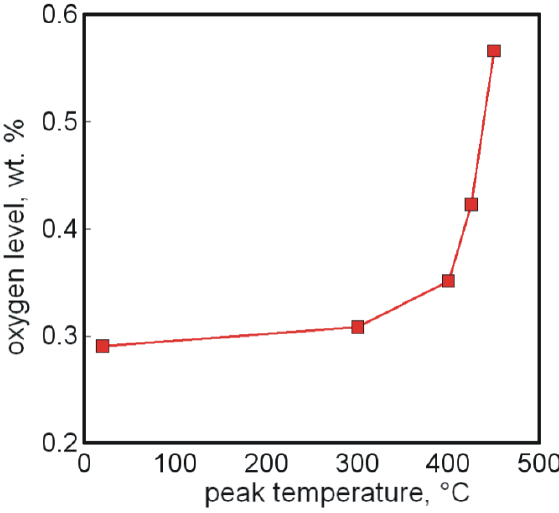
Figure 3. Oxygen content versus debinding temperature for titanium powder